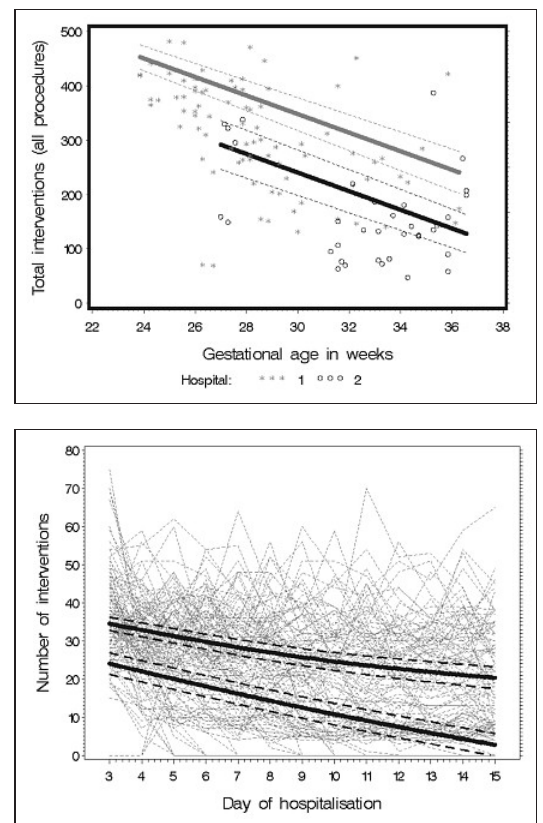
Figure 3 Number of proce- dures per child dur- ing the first 14 days of life and average trend over all chil-